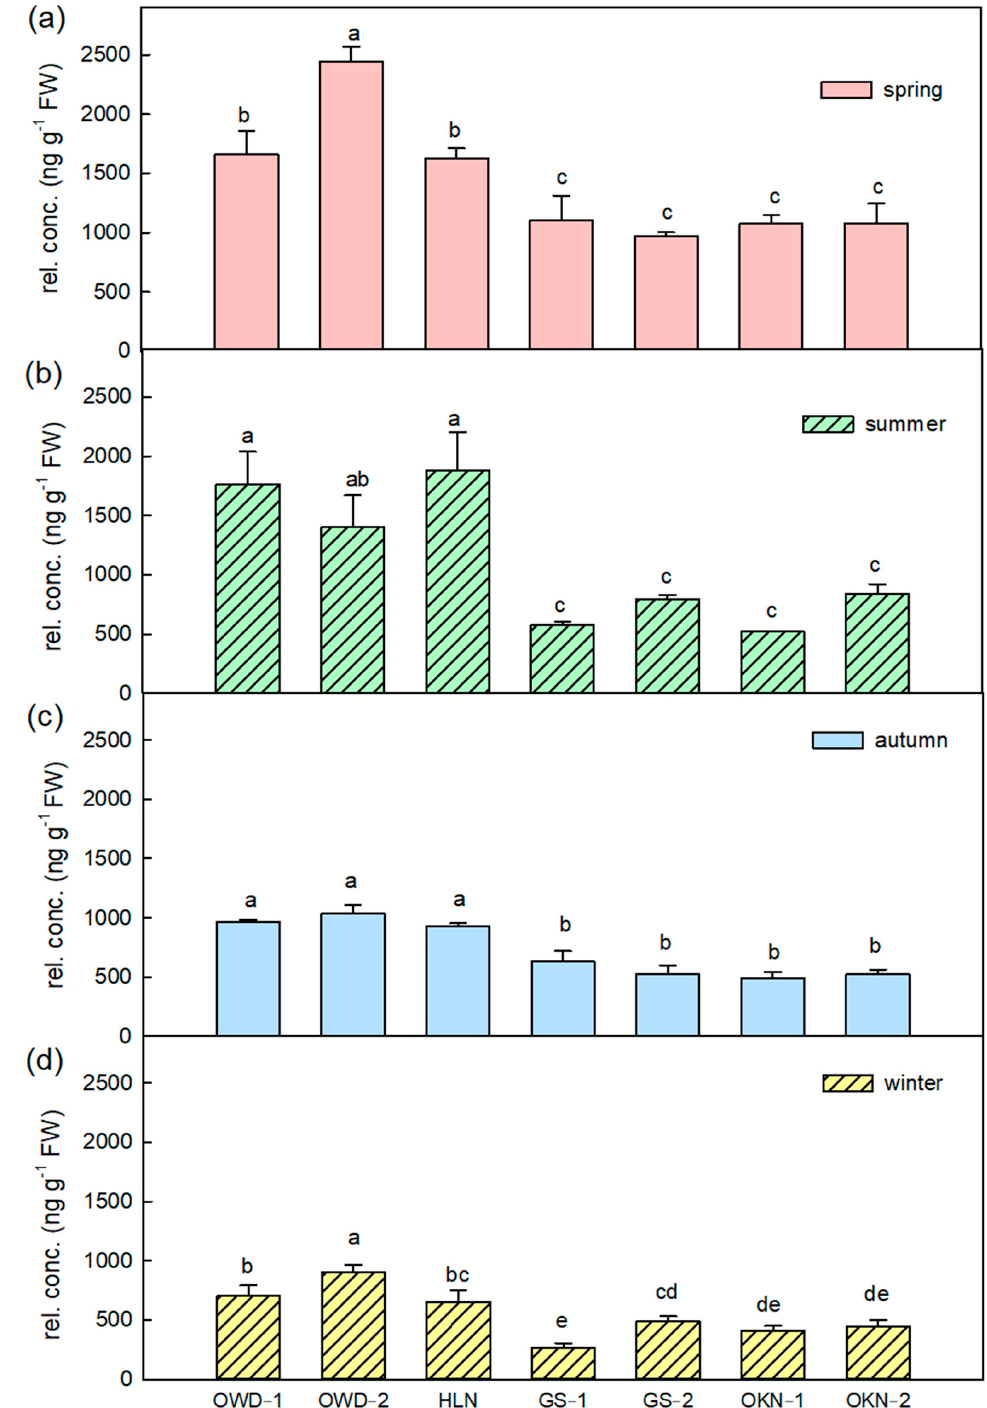
Figure 2. The linalool variations in Citrus depressa fresh leaf among all accessions in each season, which is ( a ) spring; ( b ) summer; ( c ) autumn; and ( d ) winter. Each bar shows the average ( n = 3) of the relative concentration (rel. conc.) The error bar was calculated by standard errors, and the different letters show a significant difference (LSD p < 0.05).